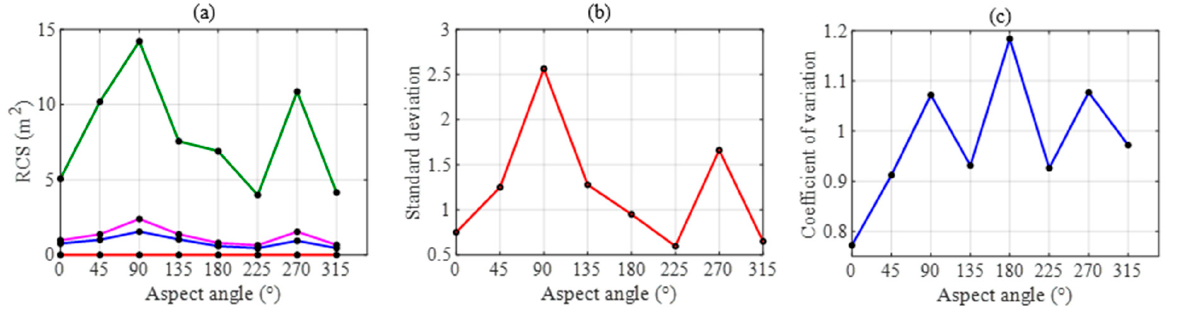
Figure 5. The RCS statistical digital features of the cooperative fishing boat vary with aspect angle. ( a ) The size of RCS; ( b ) standard deviation; ( c ) coefficient of variance.